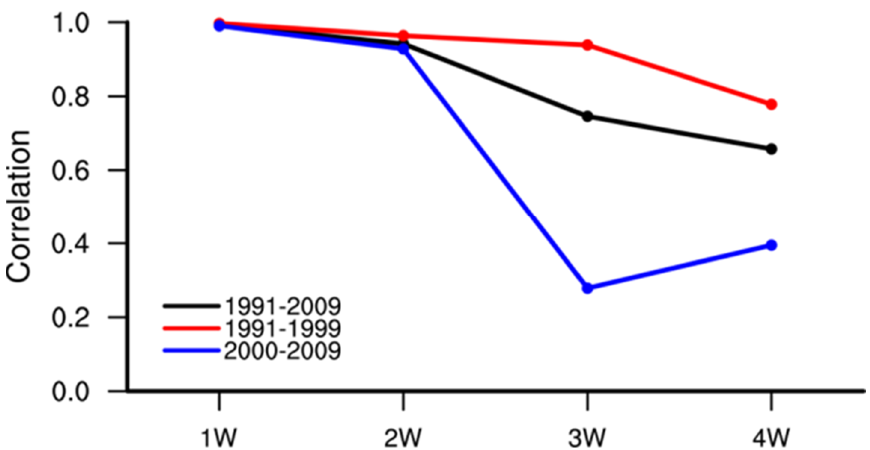
Figure 4. East Asia winter monsoon (EAWM) prediction skills from ERA–Interim and Glosea5 with lead times of 1–4 weeks. Black , red , and blue lines are averaged for 1991–1999, 1991–1999, and 2000–2009, respectively.